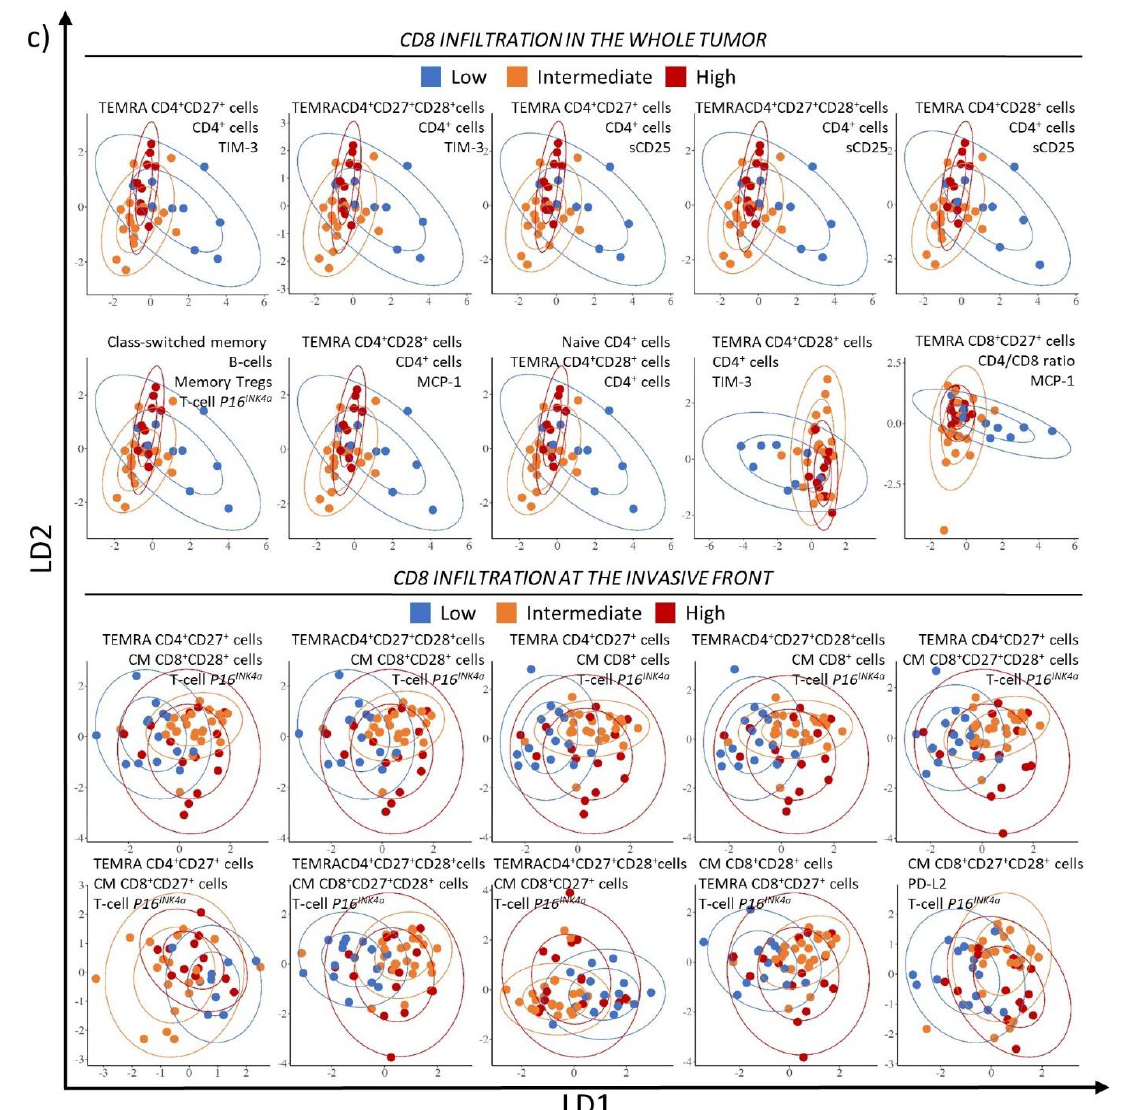
Figure 2. Linear discriminant analysis (LDA) plots of the blood biomarker panels predicting the tumor immune infiltrate in the whole group, with the LD1 coordinate on the x-axis and the LD2 coordinate on the y-axis. Confidence ellipsoids are added as well (66 and 95%). The top 10 highest ranked blood biomarker panels are shown (Table 3). The sTIL ( a ), CD3 ( b ) and CD8 ( c ) infiltration blood biomarker panels are shown. For sTILs a low infiltration corresponded with less than 10% sTILs, an intermediate infiltration with a sTILs percentage between 10 and 40% and a high infiltration with more than 40% sTILs. The cut offs for a low, intermediate or high infiltration were based on IQR of the CD3 and CD8 densities in the whole cohort. A low infiltration reflected tumors with a density in the lower quartile (lowest 25%), while those of high infiltration were the ones with a density in the upper quartile (highest 25%). Tumors with a low infiltration are shown in blue, an intermediate infiltration in orange and a high infiltration in red.